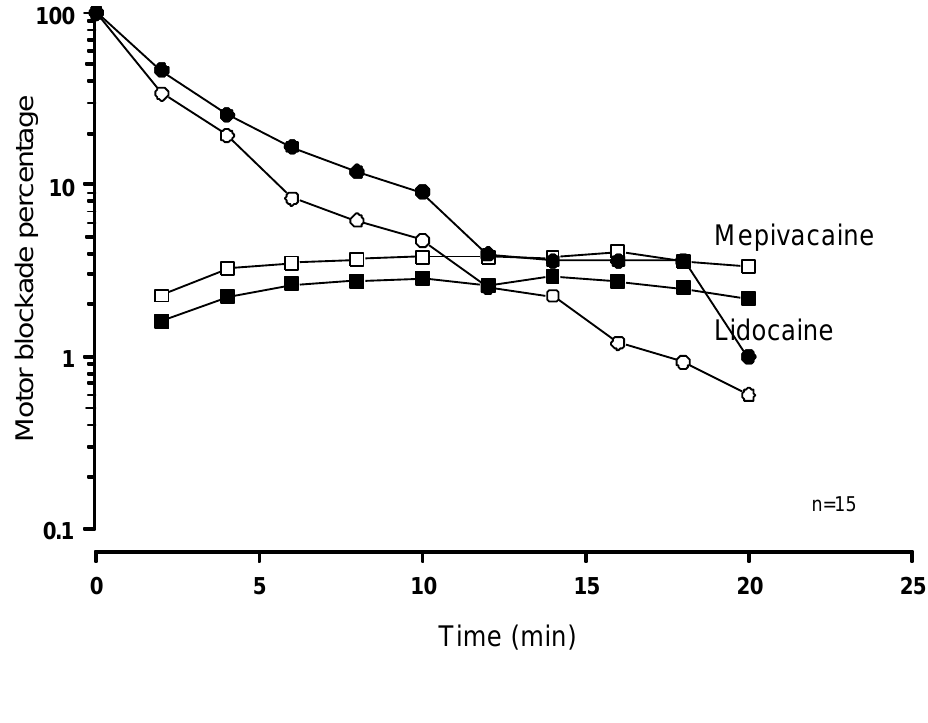
FIGURE 4 . Mean percentage motor blockade (dots) and mean plasma concentration–time curves (squares) of lidocaine (solid symbols), and mepivacaine (open symbols) after axillary administration of 600 mg (+ 5 m g ml –1 adrenaline) (n = 15). Decrease in motor blockade can be tested only before surgery, while testing of the recovery is not possible due to